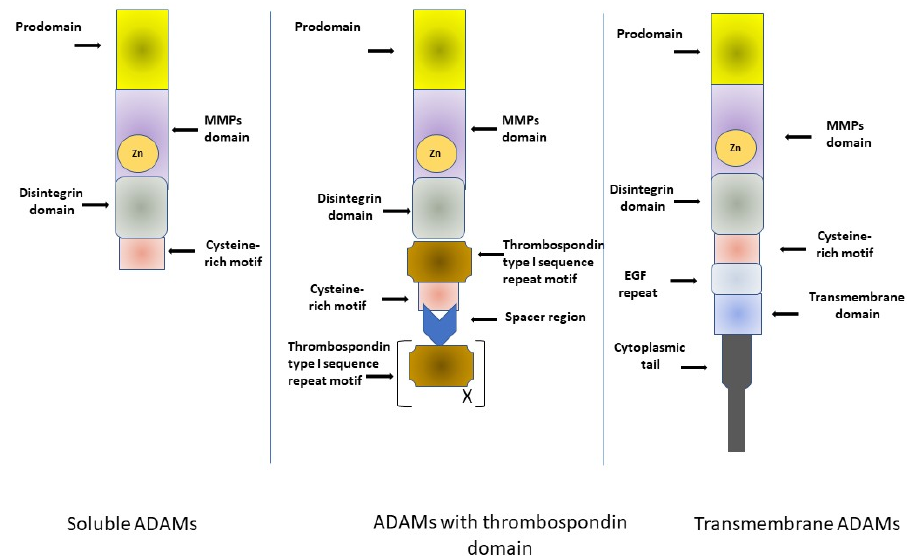
Figure 1. Comparative structure of a disintegrin and metalloproteinase ADAMs family members [27,35–38]. EGF, epidermal growth factor; MMPs, matrix metalloproteinases.